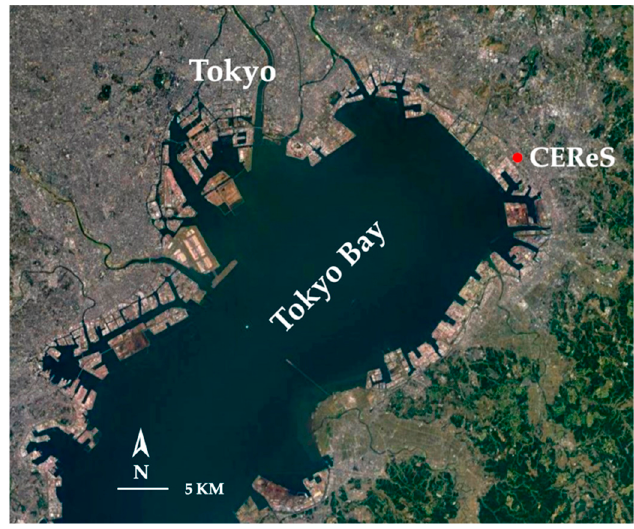
Figure 1. Study area and location of the SKYNET site in Chiba University (35.62° N, 140.10° E), Japan. The observation site at Chiba University is located in the urban Chiba area, about 30 km southeast of Tokyo.